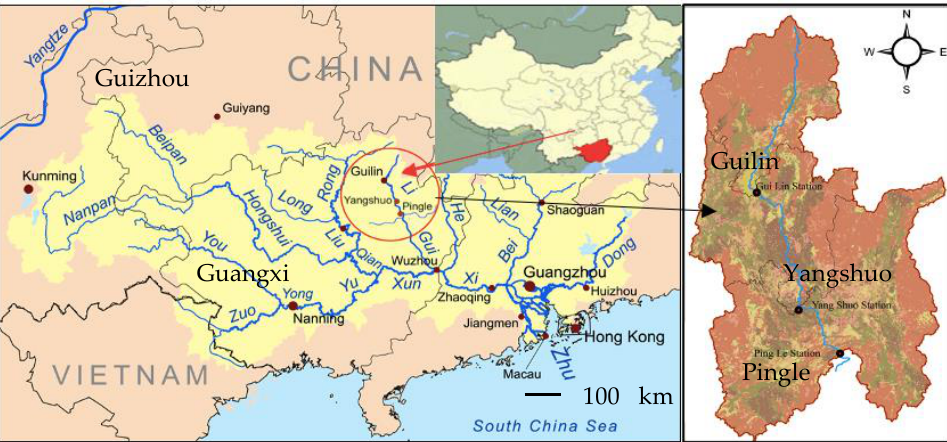
Figure 1. Lijiang River situation and its three subbasins (Guilin, Yangshuo, and Pingle). The demographic Hu Line is presented in blue on the country map.